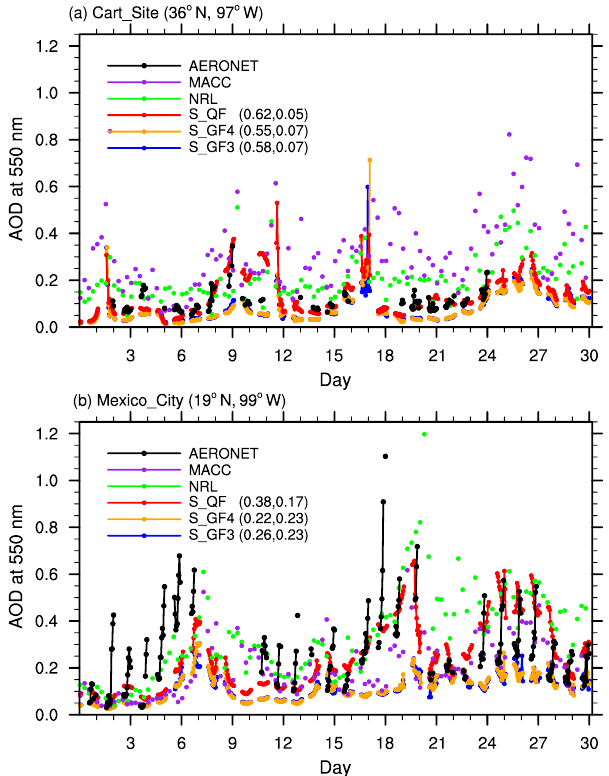
Figure 4. Time series of hourly regional mean AOD in April 2009 from group A simulations, reanalysis data and AERONET retrievals at AERONET sites. Numbers in parentheses denote TCC (left) and RMSE (right) between each simulation and AERONET